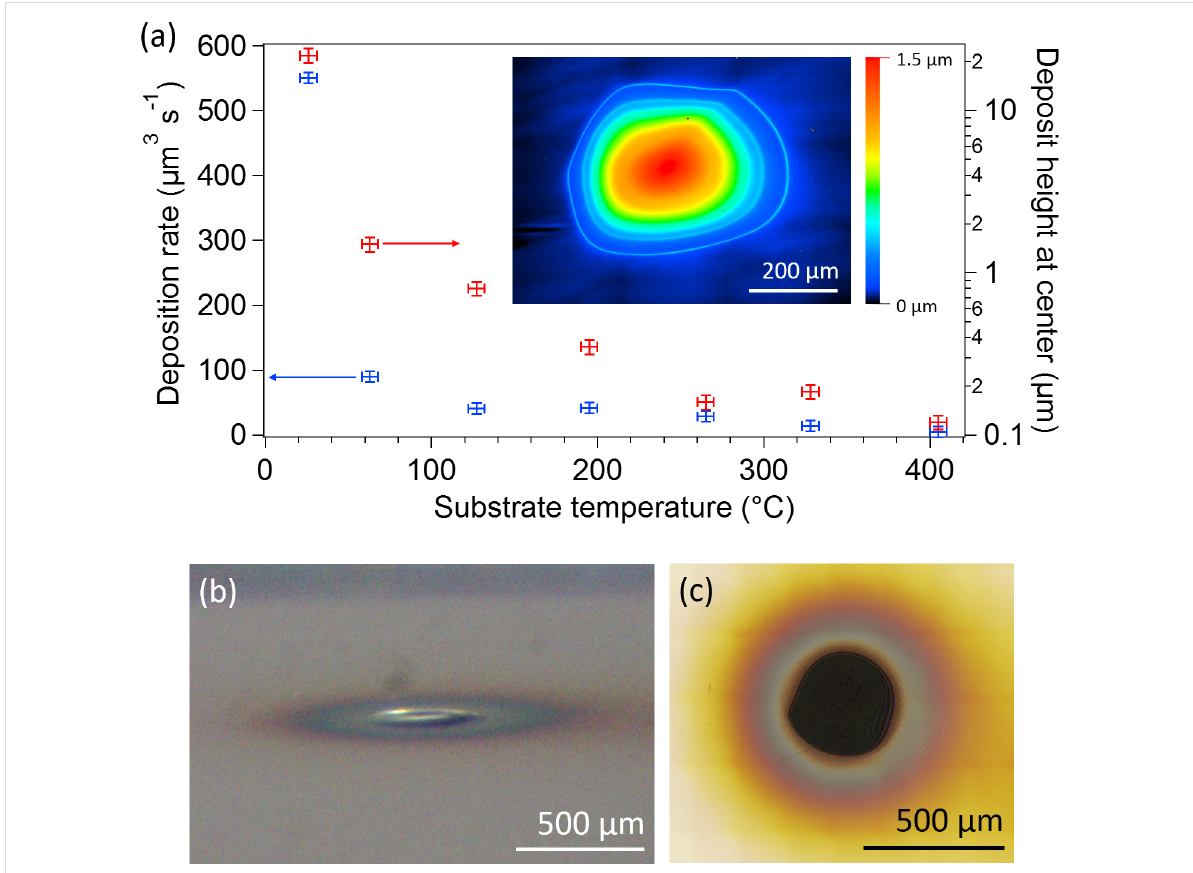
Figure 2: (a) Deposition rate of EBID using TMB precursor and a 2 keV, 20 μ A Gaussian electron beam as a function of the silicon substrate temper- ature. Inset: LCSM height map of the deposit fabricated at a substrate temperature of 63 °C. (b) Side-on, in situ optical image of deposit produced by the large-area EBID system. The deposit was fabricated by performing EBID using TMB precursor on a room temperature copper-coated silicon sub- strate for 30 min. (c) LCSM optical image of the deposit shown in